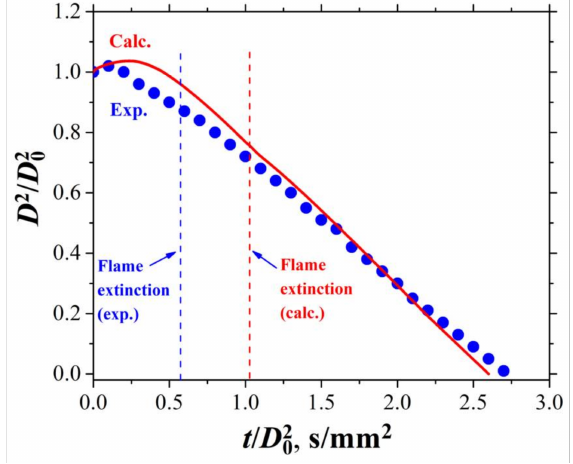
ratio for the combustion of an 0